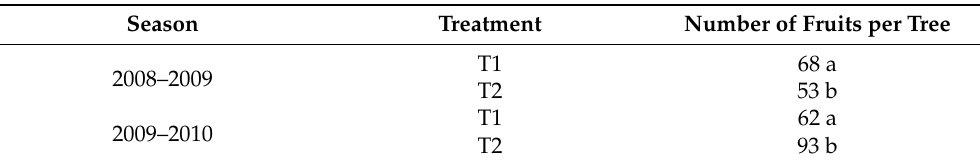
Table 4. Number of fruits per ‘Brookfield Gala’ apple tree at harvest for two water